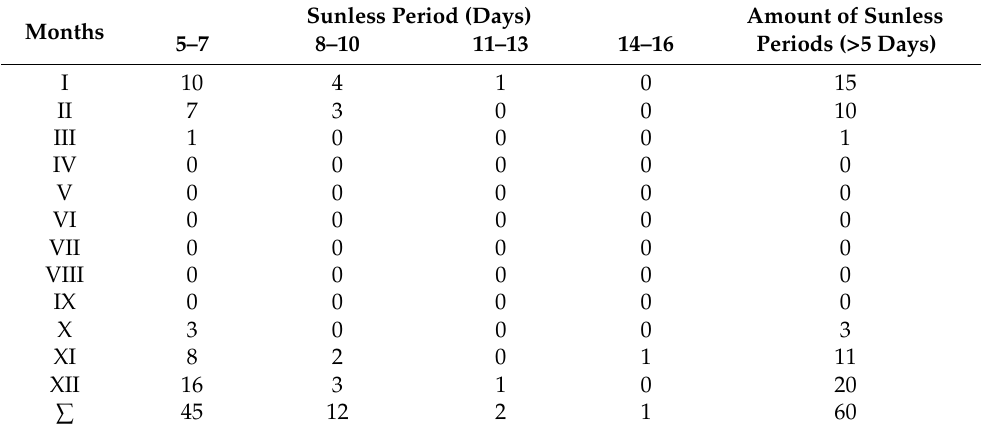
Table 3. The number of compact sunless periods of at least 5 days in Kołobrzeg in the years 1996–2015.